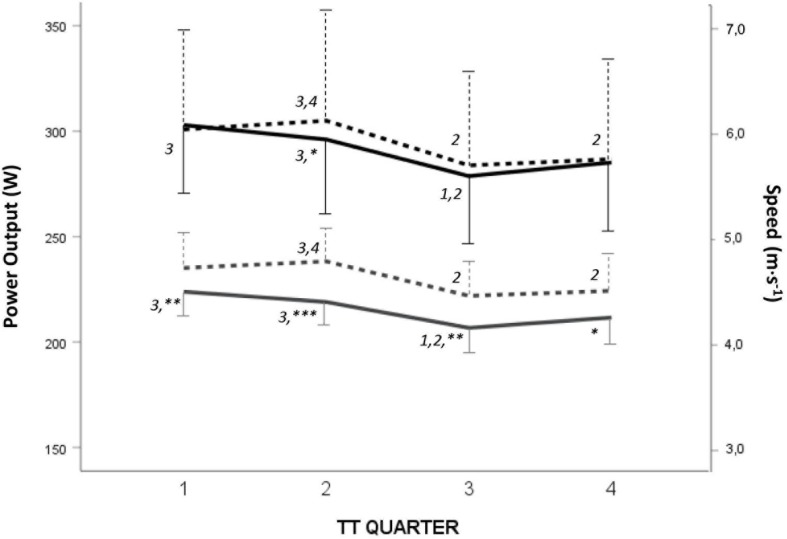
Mean power output (black lines) and speed (gray lines) for each quarter (1–4) of the maximal time trial (TT: 225 m each for females, 250 m each for males) when skiing with (WR; intact line) and without (NR; dashed line) the rifle. Different from NR: ∗p < 0.05, ∗∗p < 0.01, ∗∗∗p < 0.001. Numbers indicate a difference from other quarters for the same condition (WR/NR), P < 0.05.